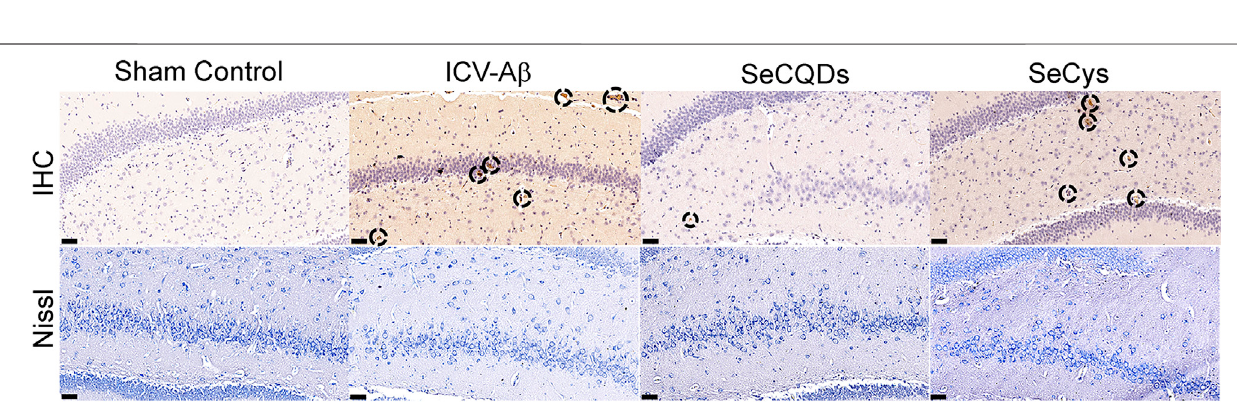
Frontiers in Pharmacology |